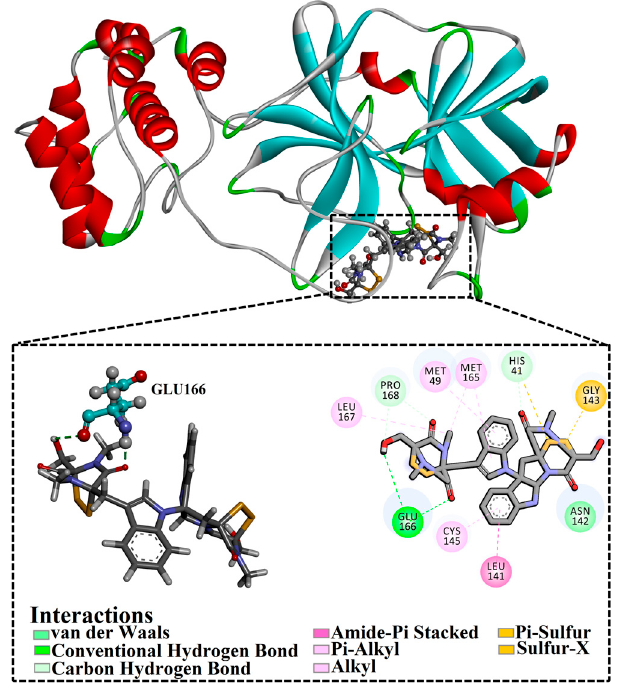
Figure 3. Three- and two-dimensional molecular interaction patterns of the binding mode of chetomin (UMHMNP1403367) with SARS-CoV-2 3CL pro .